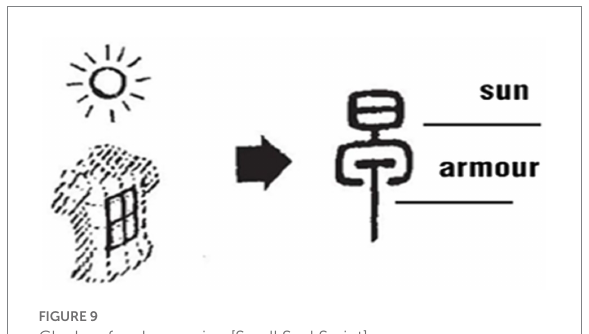
FIGURE 9 Glyphs of early morning [Small Seal Script].